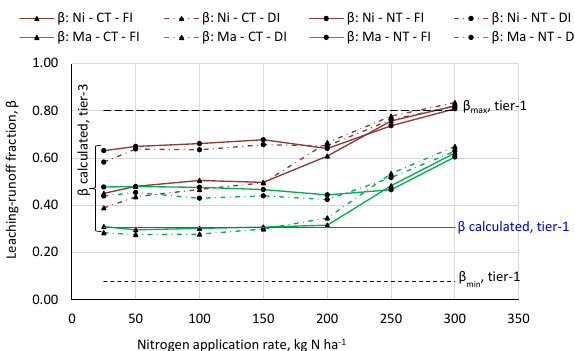
Figure 9. N leaching–runoff fractions β for different management packages and N application rates following from the tier-1 or tier-3 approach. Red lines refer to nitrate (Ni); green lines refer to ma- nure (Ma). Circular markers refer to no-tillage (NT); triangular markers refer to conventional tillage. Dashed lines refer to deficit irrigation (DI); solid lines refer to full irrigation (FI).